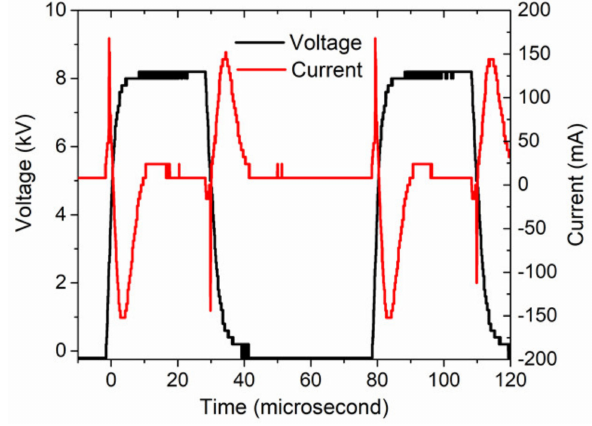
Figure 2. A typical waveform of applied voltage and plasma